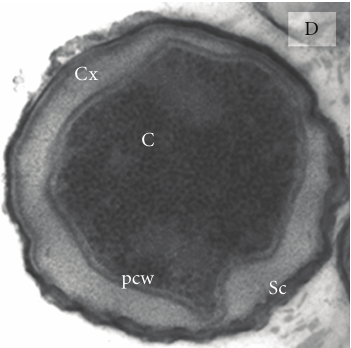
Figure 1: Electron micrograph of a B. cereus spore, 146.000x. c, spore core; cx, spore cortex; sc, spore coat; pcw, primordial cell wall. Adapted from Scheldeman et al. [3].